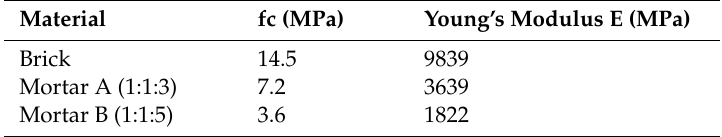
Table 1. Compressive strength (fc) and Young’s modulus (E) of mortars and bricks.